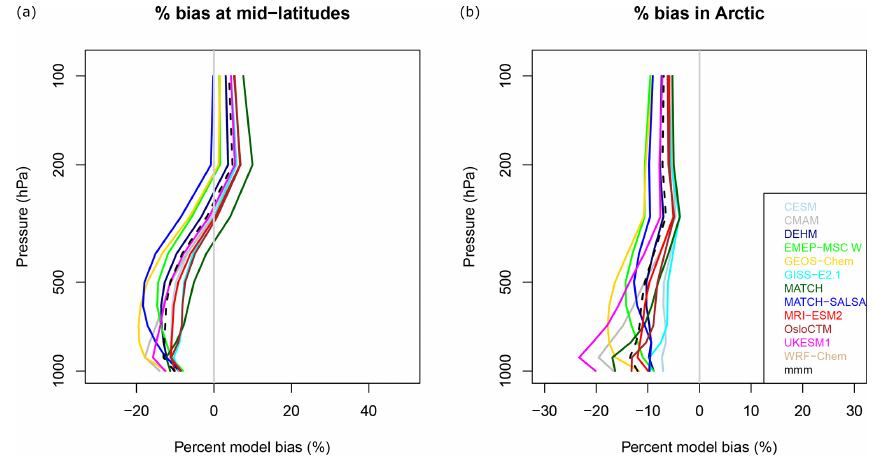
Figure 9. Vertical distribution of models’ O 3 percent biases (model minus measurement over measurement) for 2008–2009 compared to the TES measurements; (a) average for midlatitudes (30–60 ◦ N) and (b) average for Arctic latitudes ( > 60 ◦ N).